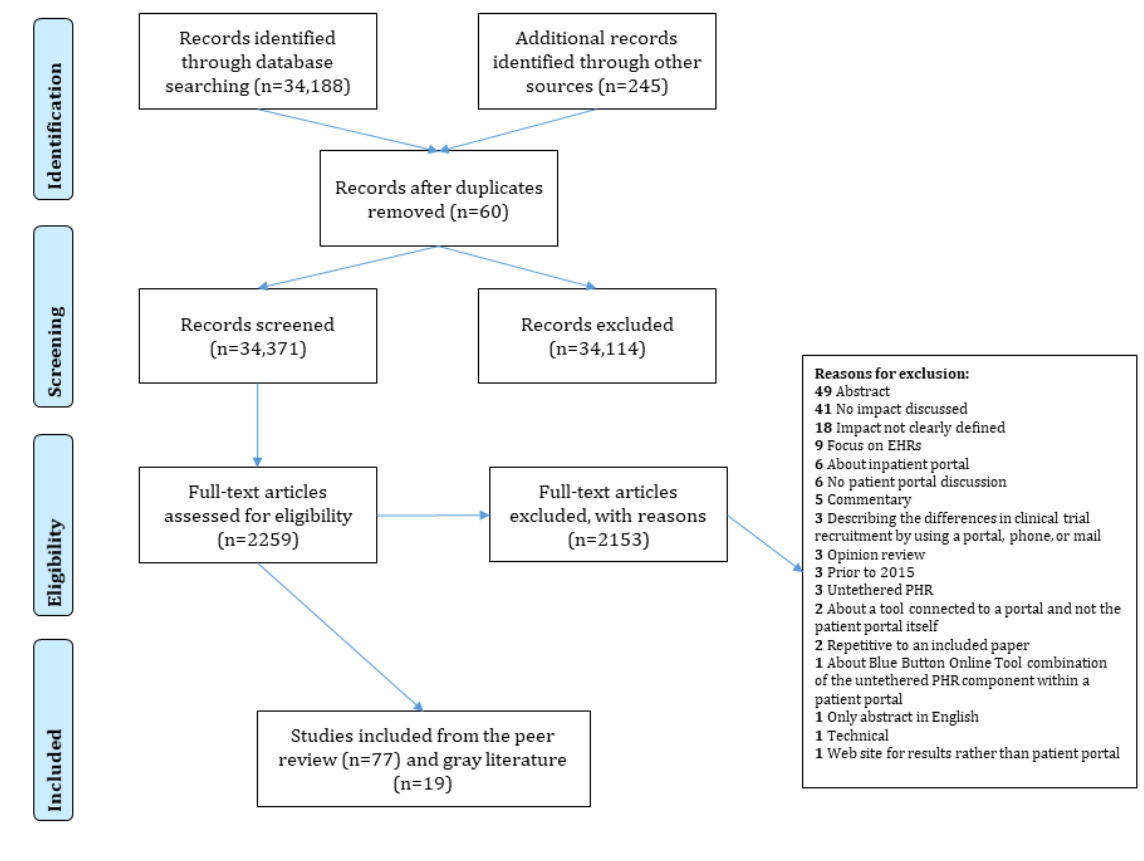
Figure 1. PRISMA (Preferred Reporting Items for Systematic reviews and Meta-Analyses) flow diagram. EHR: electronic health record; PHR: personal health